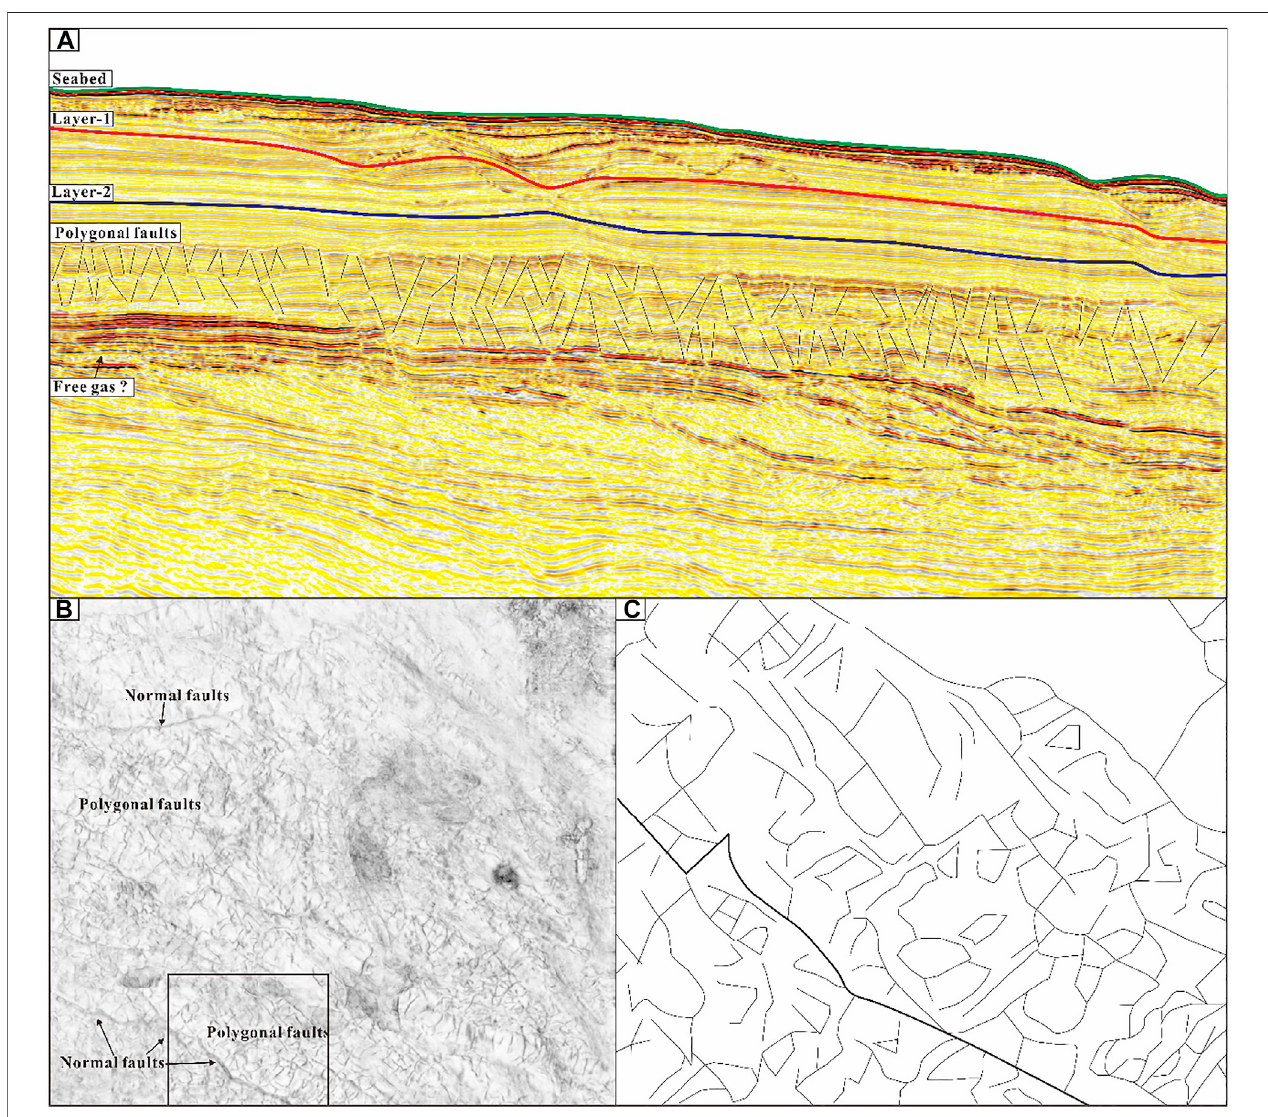
FIGURE 2 | (A) A seismic pro fi le in east-west direction in the Pearl River Mouth Basin, northern South China Sea showing the distribution of PFs overlying the high amplitude re fl ections which are interpreted to be free gas; (B) A coherence map of a seismic re fl ection crosscutting the PFs in the Pearl River Mouth Basin, showing the plane form of polygonal faults and normal faults; (C) Enlarged sketch of the black rectangle in Figure 2B , showing the map-view random polygonal fault patterns.